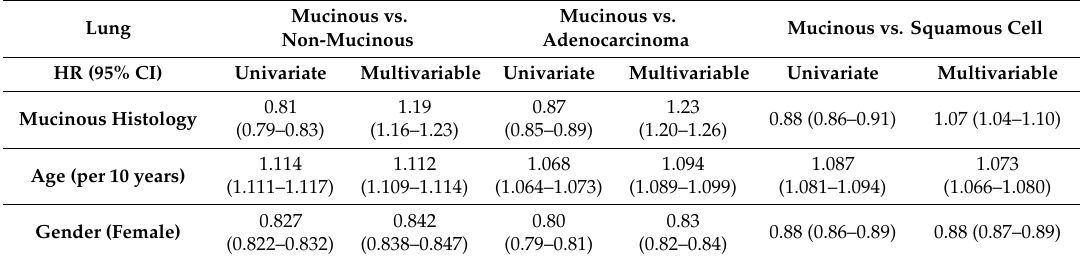
Table 6. Derived univariate and multivariable Cox-proportional hazard ratios (HR) of mortality for lung